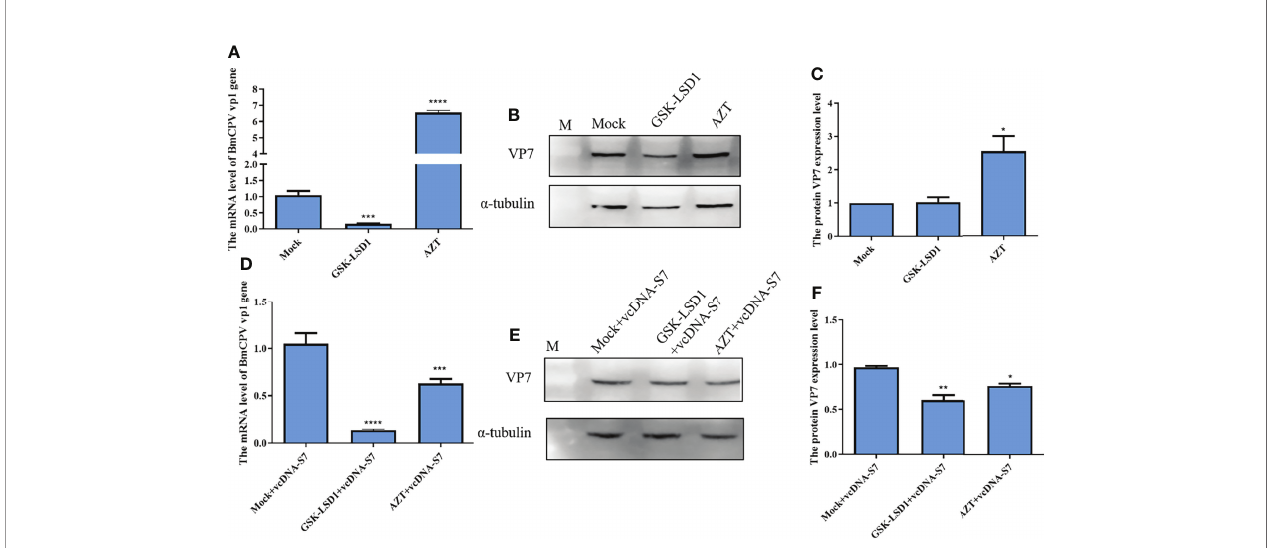
FIGURE 6 | Endogenous reverse transcriptase activity inhibited BmCPV infection. (A – C) Endogenous reverse transcriptase activity inhibited virus infection in BmN cells. 1×10 6 BmN cells were pre-treated with 5 mM AZT or 50 nM GSKLSD1 and infected with BmCPV for 24 h. The relative RNA level of BmCPV vp1gene was determined by real-time PCR (A) . The protein level of VP7 was analyzed by western blotting (B) . The grayscale of western blotting signal bands is analyzed by software Image J (C) . (D – F) Effect of endogenous reverse transcriptase activity on the inhibitory effect of vcDNA-S7 on virus. 1×10 6 BmN cells were pre-treated with 5mM AZT or 50 nM GSKLSD1 and were transfected 1 m g vcDNA-S7 for 24 h. Then, the cells were infected with BmCPV for another 48 h. The relative RNA level of BmCPV vp1gene was determined by real-time PCR (D) . The level of VP7 protein was analyzed by western blotting (E) . The grayscale of western blotting signal bands is analyzed by software Image J (F) . (n=2, * P <0.05; ** P <0.01; *** P<0.001 ; **** P<0.0001 ).